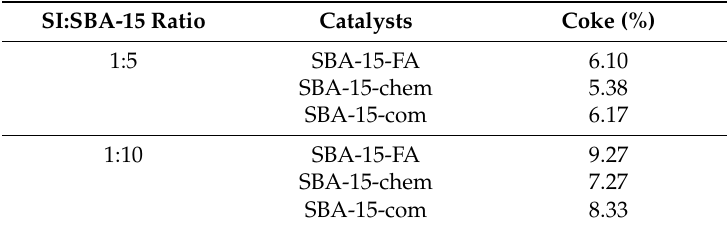
Table 3. Relative amount (wt %) of coke deposited on spent SBA-15